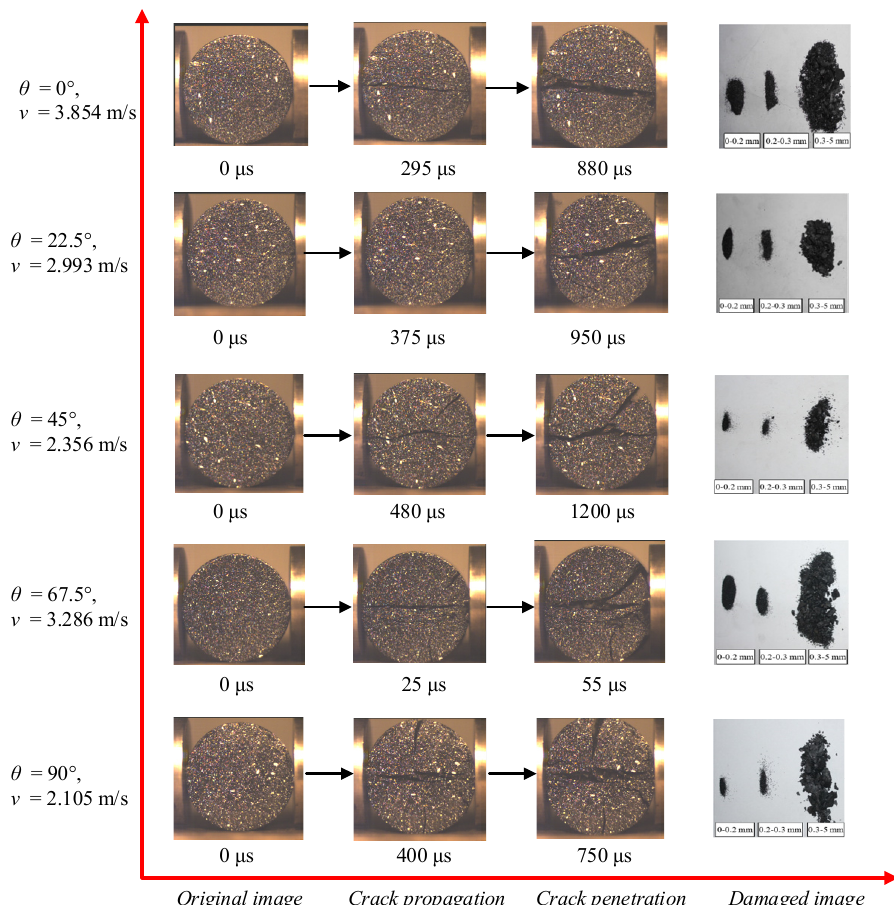
Figure 13. Crack propagation process and fragment distribution in representative outburst-prone coal.